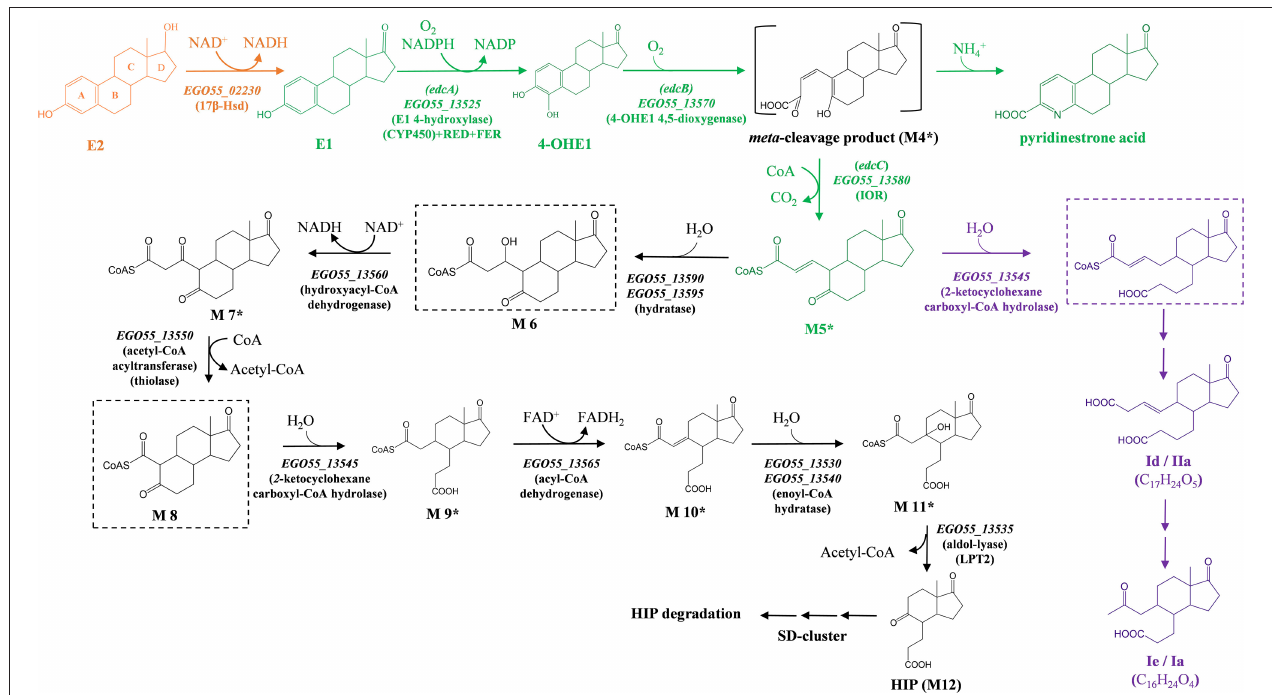
FIGURE 1 | Proposed estrogen degradation pathway in N. tardaugens NBRC 16725. Compound names are indicated with an abbreviation: (E2) estradiol; (E1) estrone; (4-OHE1) 4-hydroxyestrone; (M5) 4-norestrogen-5(10)-en-3-oyl-CoA; (Ie/IIa) 3a α - H -4 α -[3 ′ -propanoic acid]-5 β -[4 ′ -but-3-enoic acid]-7a β -methyl-l-indanone; (Id/Ia) 3a α - H -4 α -[3 ′ -propanoic acid]-5 β -[2’-ketopropyl]-7a β -methyl-l-indanone; and (HIP) 3a α -H-4 α (3 ′ -propanoate)-7a- β -methylhexahydro-1,5-indanedione. Enzyme names are (17 β -Hsd) 3 β , 17 β -hydroxysteroid dehydrogenase; (EdcA) E1 4-hydroxylase; (EdcB) 4-OHE1 4,5-dioxygenase; and (EdcC) meta -cleavage product decarboxylase. The catalytic genes of N. tardaugens are indicated in italics, with the nomenclature EGO55_xxxxx. We indicate in orange the metabolic steps confirmed in our previous study (Ibero et al., 2019a); in green, those genes, enzymes, metabolites, and reactions covered in the present study; in purple, the proposed lateral pathway leading to dead-end products Ie/IIa and Id/Ia; and in black, metabolic steps described in previous studies (Chen et al., 2017; Wu et al., 2018). Only metabolites identified through mass spectrum are marked with asterisk, while the rest have been confirmed using NMR or authentic standards. Hypothetical metabolites are boxed in dashed-line